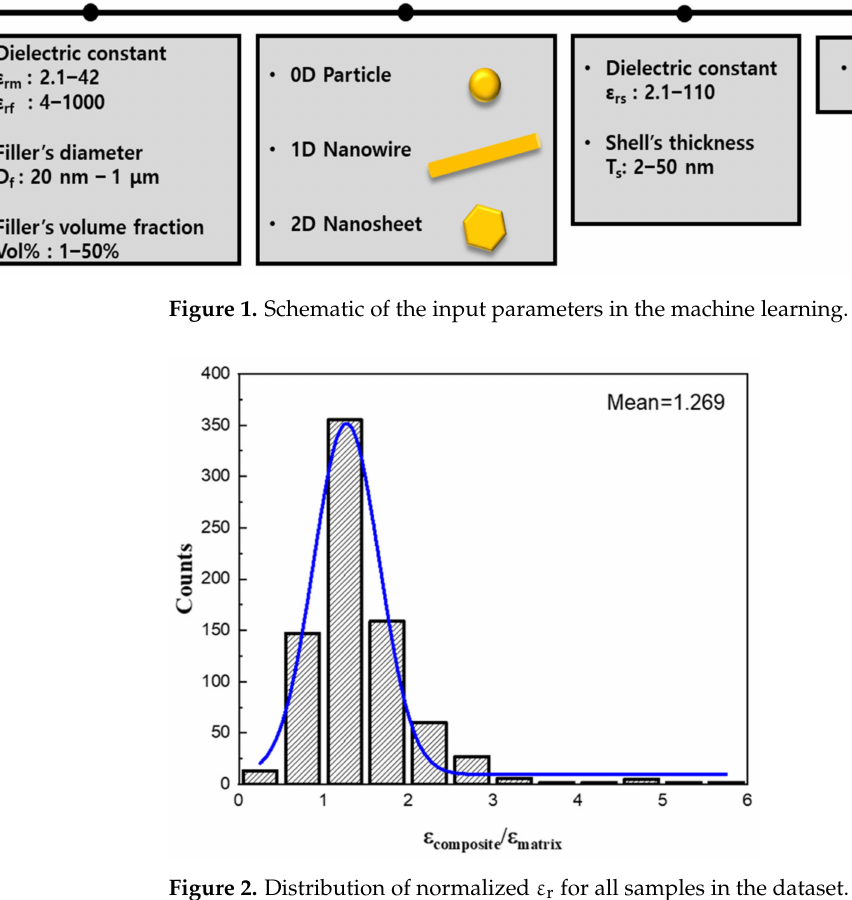
Figure 2. Distribution of normalized ε r for all samples in the